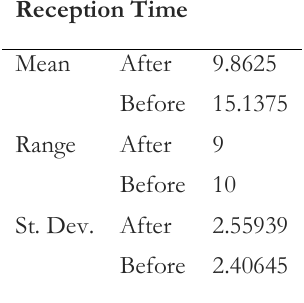
Table 7. The improvement of reception